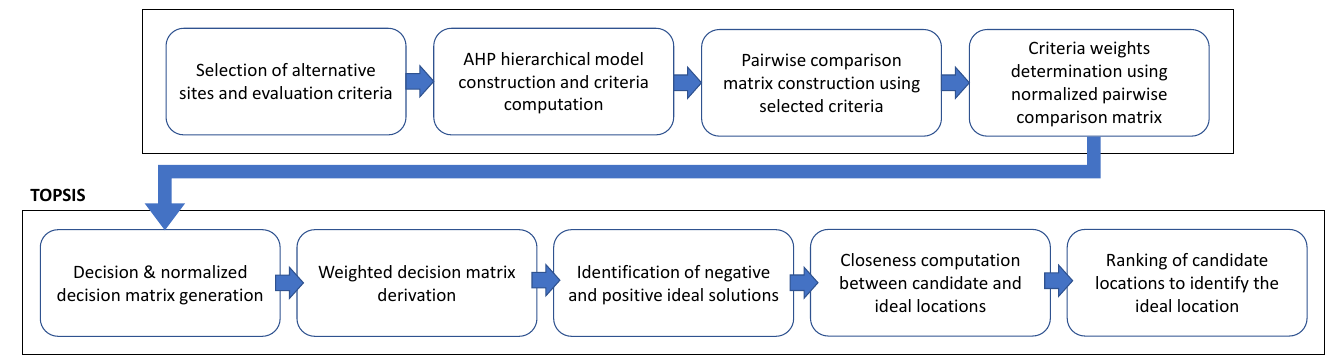
Figure 1. Flow of the important steps in the AHP/TOPSIS